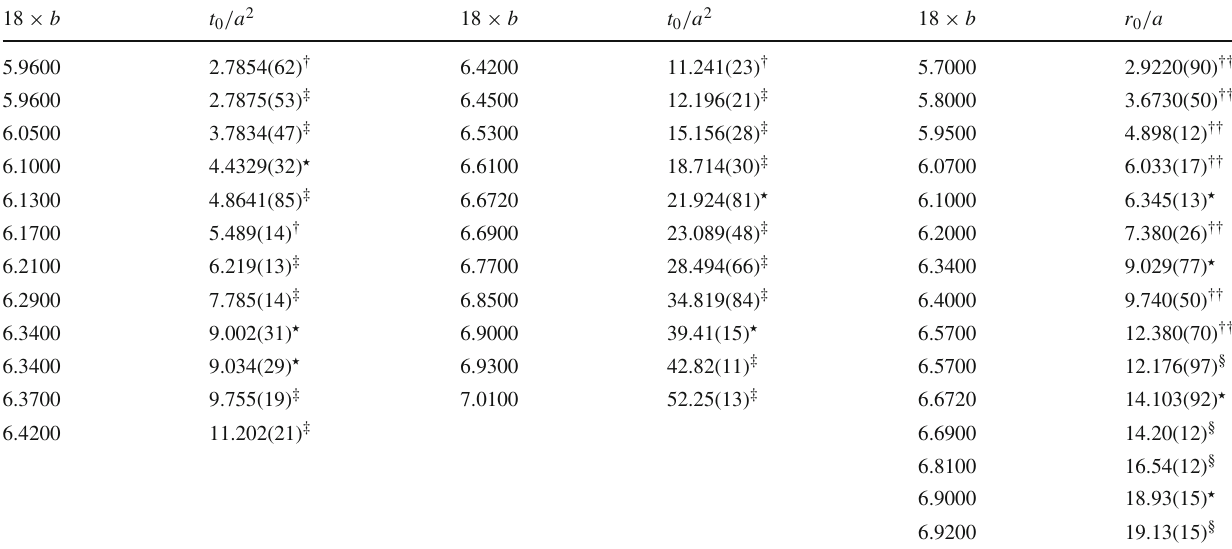
/( 2 μ ) obtained through the different methods explained in the text as a function of the matching scale with perturbation Fig. 3 Ratio (cid:2) had MS theory ( μ ref ≡ 2 μ had ). The grey band corresponds to the final result obtained from a linear fit to the 3 last steps in the SF sequence Table3 Resultsfor t 0 / a 2 and r 0 / a fordifferentvaluesof b .Forthecase fromthevaluesof r c / a of[60]togetherwith r c / r 0 = 0 . 5133 ( 24 ) which of t 0 / a 2 therelevantreferencesare † [20], ‡ [57], (cid:15) [58].For r 0 / a ,instead, gives the quoted values of r 0 / the results are from †† [59] and (cid:15) [58]. The data labelled § is obtained